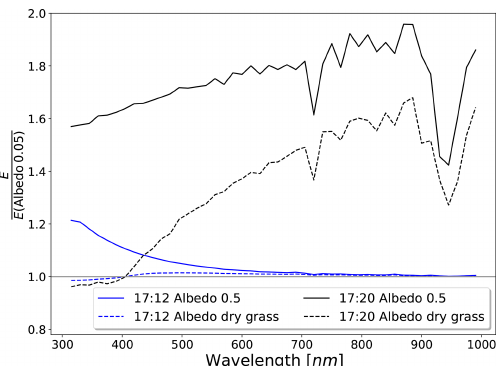
Figure 9. Relative spectral irradiance at 17:20:00 (totality) and 17:12:00UTC (partial eclipse) for different spectral, spatially ho- mogenous distributions of the surface albedo. Values are normalized to the corresponding values obtained at17:12:00 and 17:20:00UTC with an albedo of 0.05.